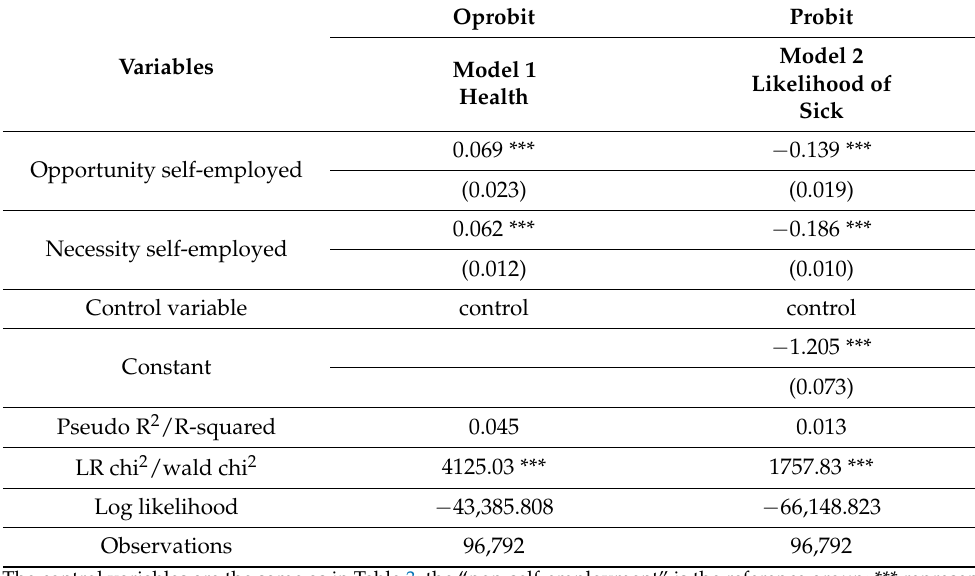
Table 6. Influence of different forms of self-employment on health.